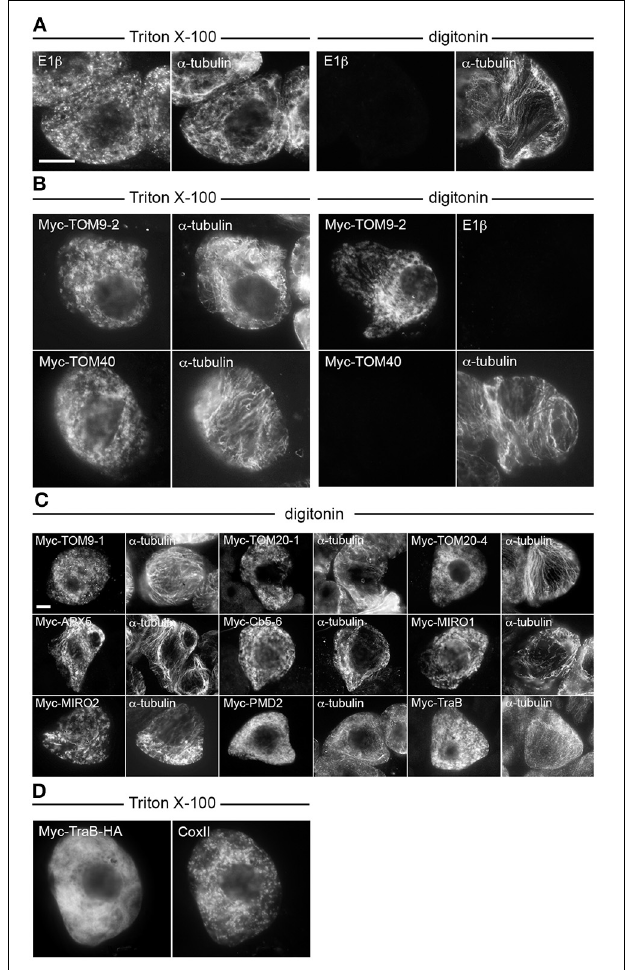
FIGURE 2 | Topological mapping of selected A. thaliana OMM-TA proteins in differentially permeabilized BY-2 cells. Non-transformed (A) or transiently-transformed (B–D) BY-2 cells were formaldehyde fixed and permeabilized (as indicated above each set of images) with either Triton X-100, which perforates all cellular membranes, or, digitonin, which selectively permeabilizes the plasma membrane, then cells were processed for immuno-epifluorescence microscopy. Also indicated in each panel is the name of the immunostained transiently-expressed Myc-tagged protein or endogenous protein (i.e., E1 β , CoxII or α -tubulin). Note that the presence or absence of immunofluorescence reflects whether the protein (epitope) was accessible to the applied antibodies. For instance, similar to α -tubulin in cytoplasmic microtubules (A) , N-terminal Myc-tagged TOM9-2 (B) and all other known or putative TA proteins examined (C) , but not endogenous E1 β in the mitochondrial matrix or the control protein, Myc-TOM40 (B) , were immunodetected in digitonin-permeabilized cells. Note also in (D) that Myc-TraB-HA did not colocalize with endogenous mitochondrial CoxII, indicating that the expressed protein, unlike Myc-TraB ( Figure 1 ) is not properly targeted to mitochondria. Bar in (A,C) = 10 μ